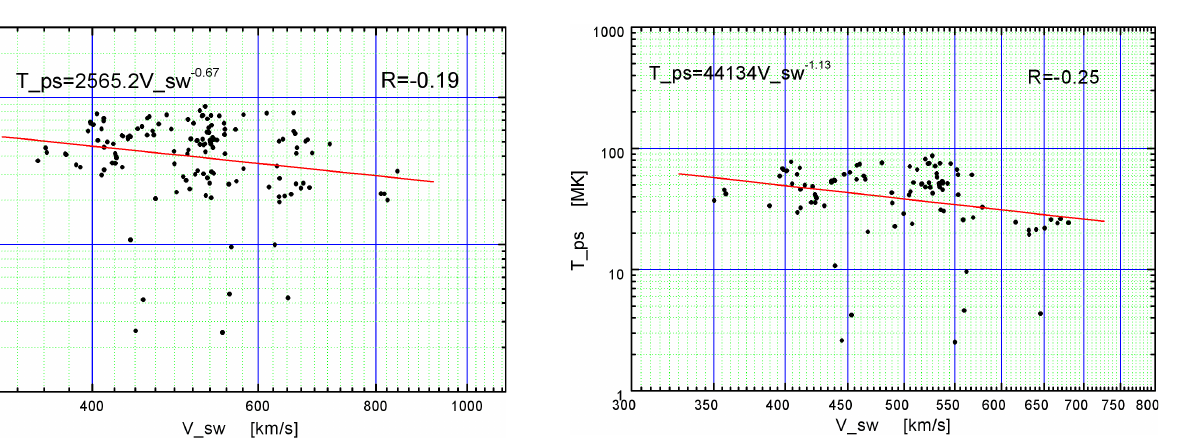
Fig. 8. The relationship between the speed of the solar wind and the ion thermal pressure in the plasma sheet while IMF Bz > − 2.0nT.